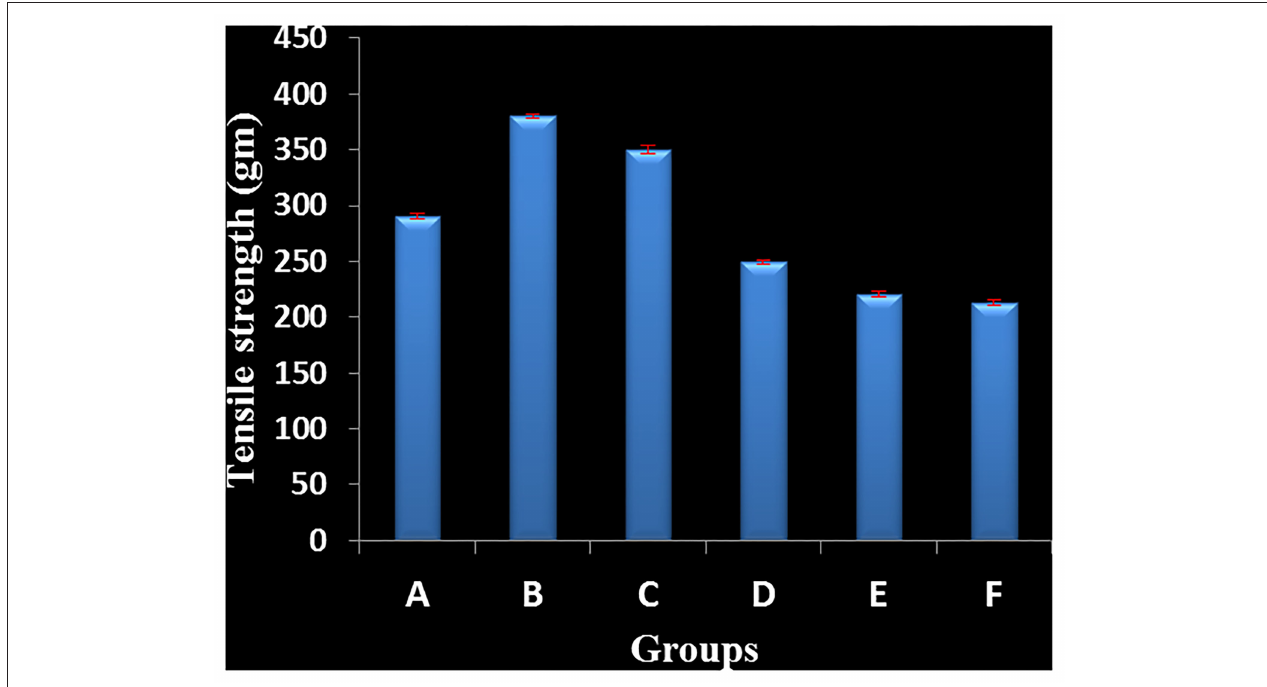
FIGURE 2 | Effect of silver nanogel on incision wound model (tensile strength) in albino Wistar rats. Group A: Test treatment group (silver nanoparticles (AgNPs) 0.1mg g − 1 ). Group B: Test treatment group (AgNPs 0.5mg g − 1 ). Group C: Test treatment group (AgNPs 1mg g − 1 ). Group D: Positive control (market drug silverex 0.2%). Group E: Group treated with gel base. Group F: Negative control (untreated group).